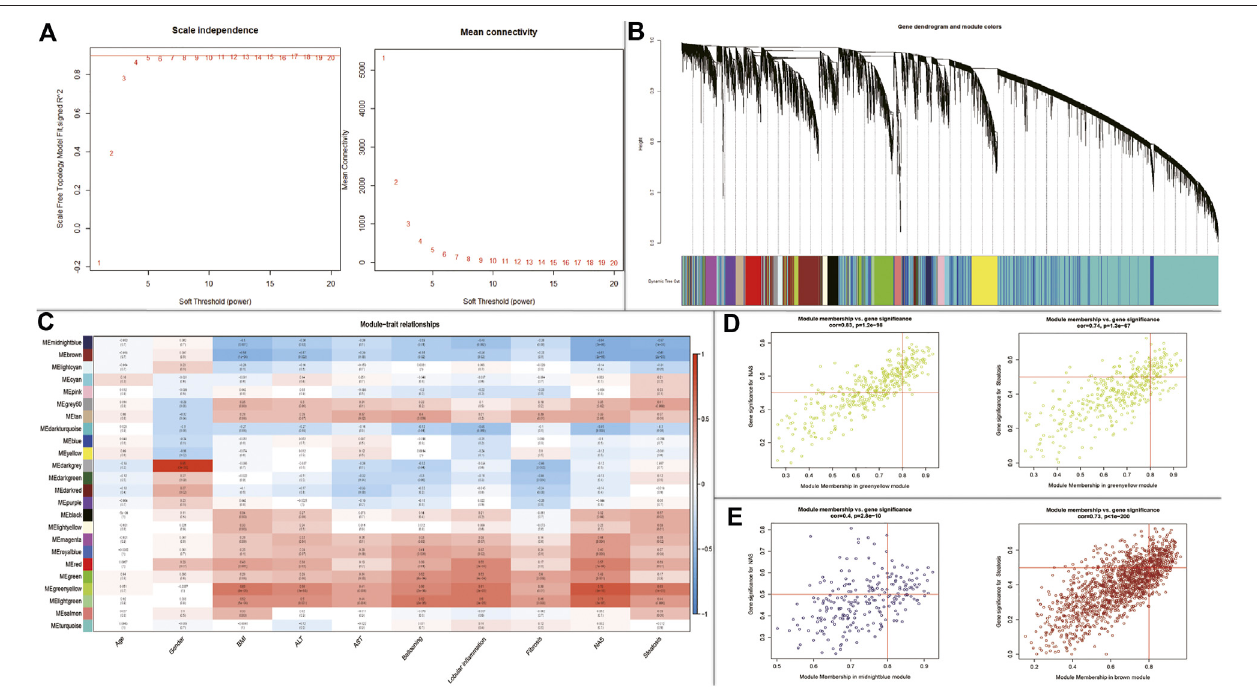
FIGURE4| WGCNAtoidentifytrait-relatedmodulesandgenes. (A) Calculatingsoft-thresholdingpower; Left: scale-free fi tindicesusingdifferentsoft-thresholding powers; Right: meanconnectivityusingdifferentsoft-thresholdingpowers; (B) ThedendrogramclusteredbyDynamicTreeCutalgorithm; (C) Theheatmappro fi lingthe correlations between module eigengenes and the clinical characteristics; (D) Scatter plot of gene signi fi cance for NAS and steatosis (Up-regulated); (E) Scatter plot of gene signi fi cance for NAS and steatosis